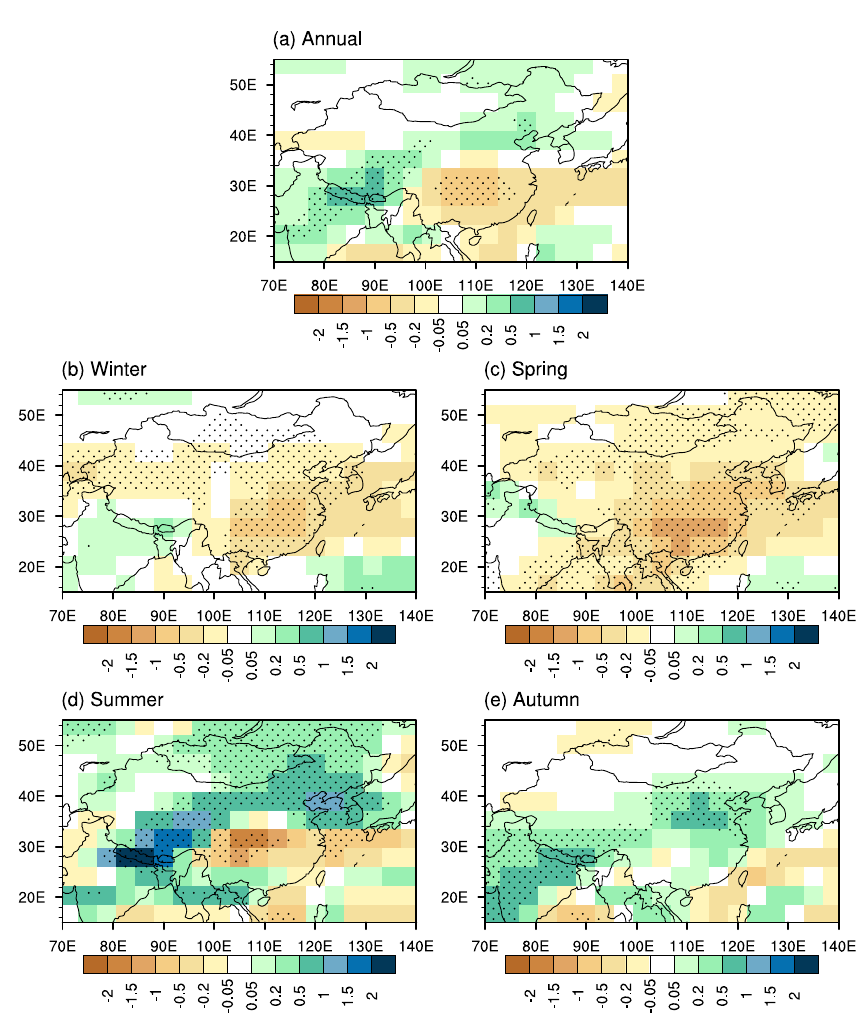
Fig. 2. Same as Fig. 1, but for precipitation changes (units:mmday − 1 )